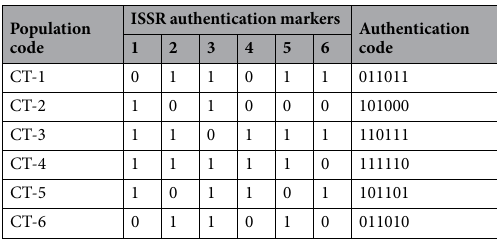
Table 3. ISSR genotypes of six C. tora populations.